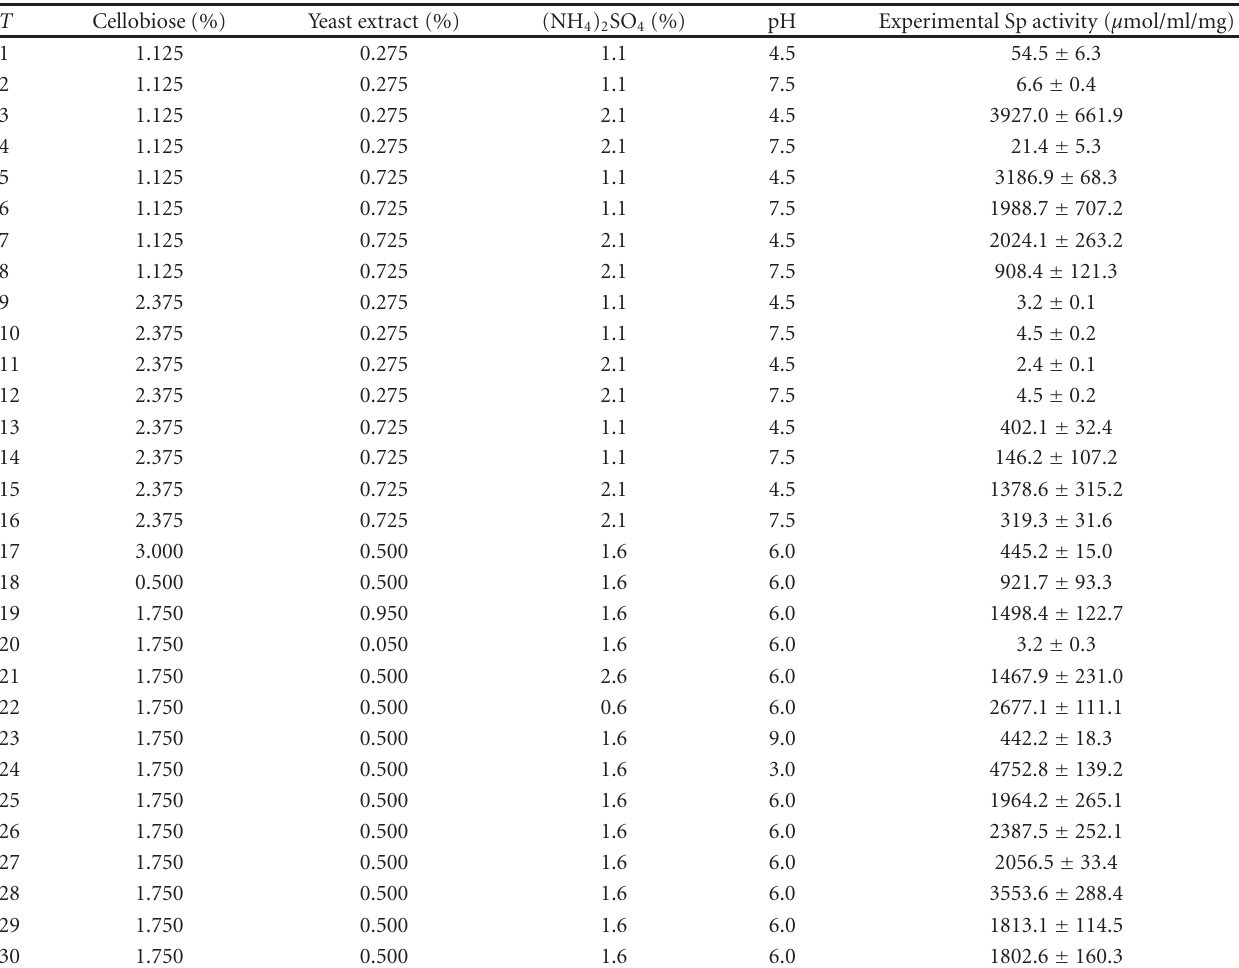
Table 2: Treatment combinations and mean response for β -glucosidase production by A. niger